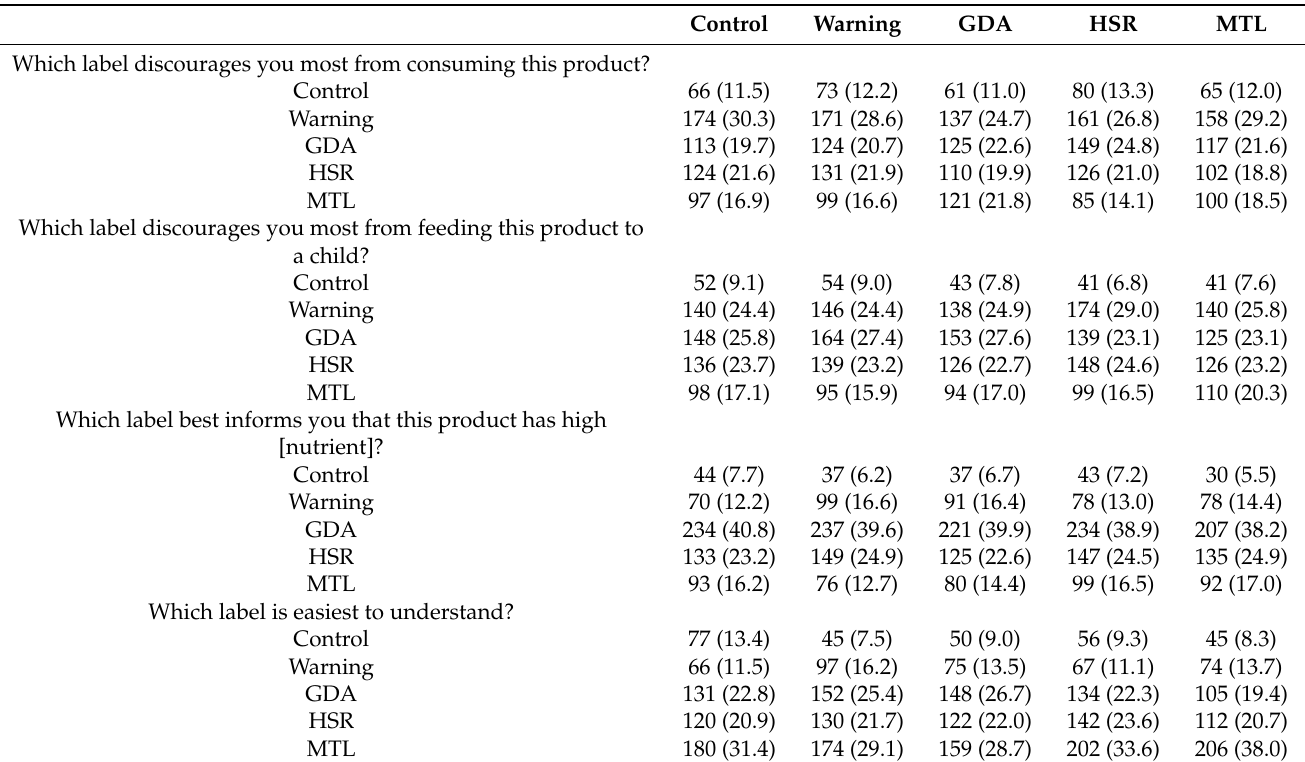
Table A3. Descriptivestatisticsforthelabelchoiceoutcomesbyarm(norepeatedmeasures), n (%)( n = 2869).